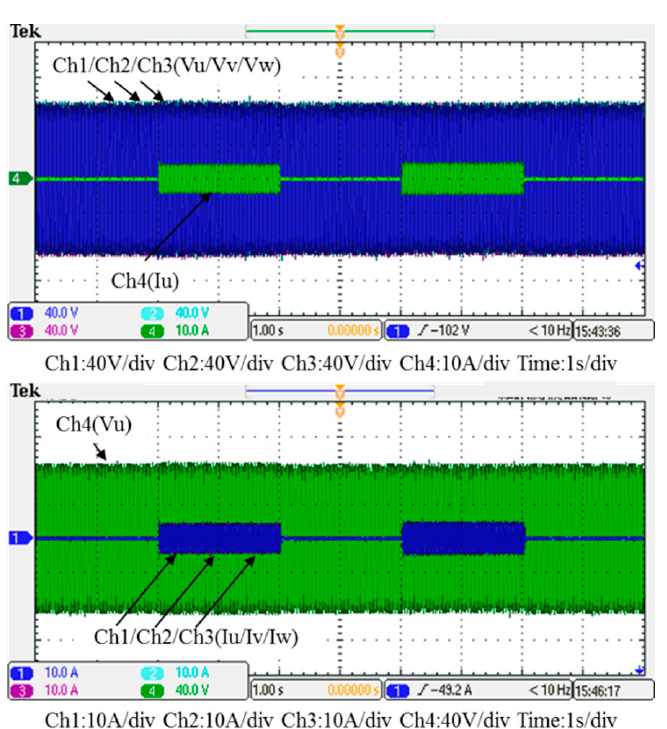
Figure 25. Case 1 implementation result: three-phase voltages and currents.